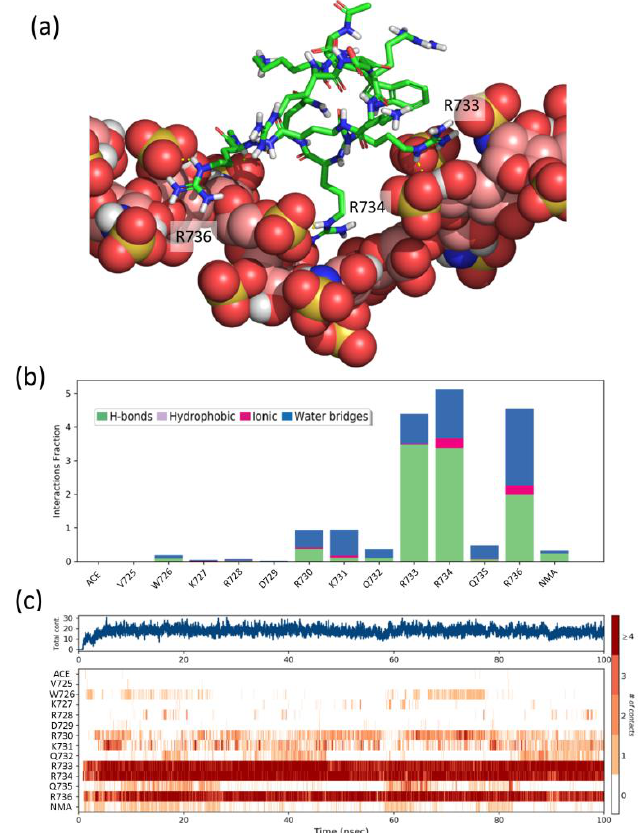
Figure 5. ( a ) Representative snapshot of the heparin/FS2 simulation. Heparin is shown as CPK balls and FS2 as sticks. ( b ) Interactions fraction per FS2 residue. The stacked bar charts are normalized over the course of the trajectory, such that a value of 1.0 suggest that the interaction is maintained over 100% of the simulation time. Values over 1.0 are possible as some residues may establish multiple contacts of same subtype. ( c ) Time dependence of the total number of interactions and of interactions between each residue of peptide FS2 and heparin. Numbering of peptide residues according to Sema3A sequence, ACE, and NMA correspond to acetyl and N-methylamide capping groups of the N- and C-termini.